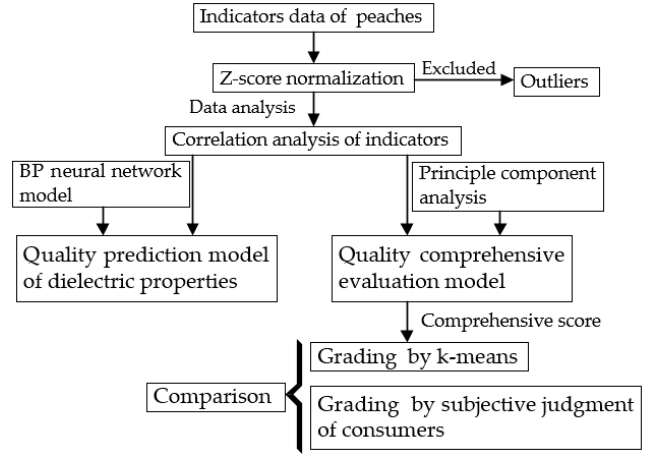
Figure 3. Outline of data processing and analysis.